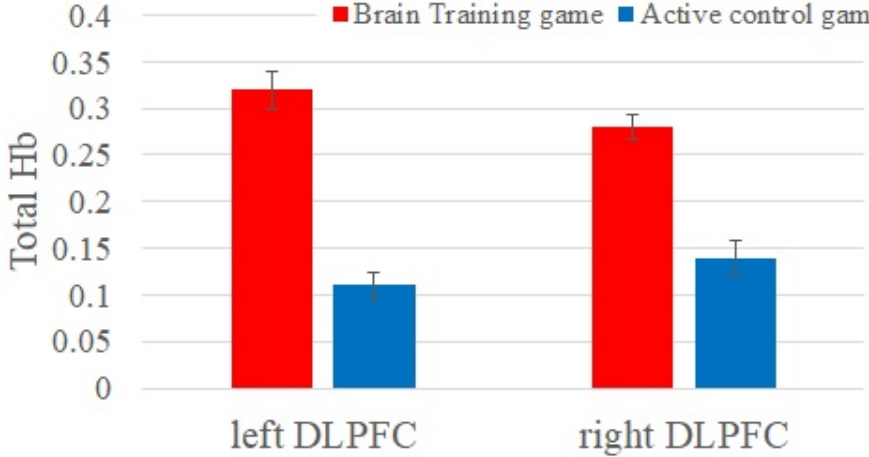
Figure 2. Brain activities measured by near-infrared spectroscopy (NIRS) while playing video games. Note: error bars are standard error (SE).